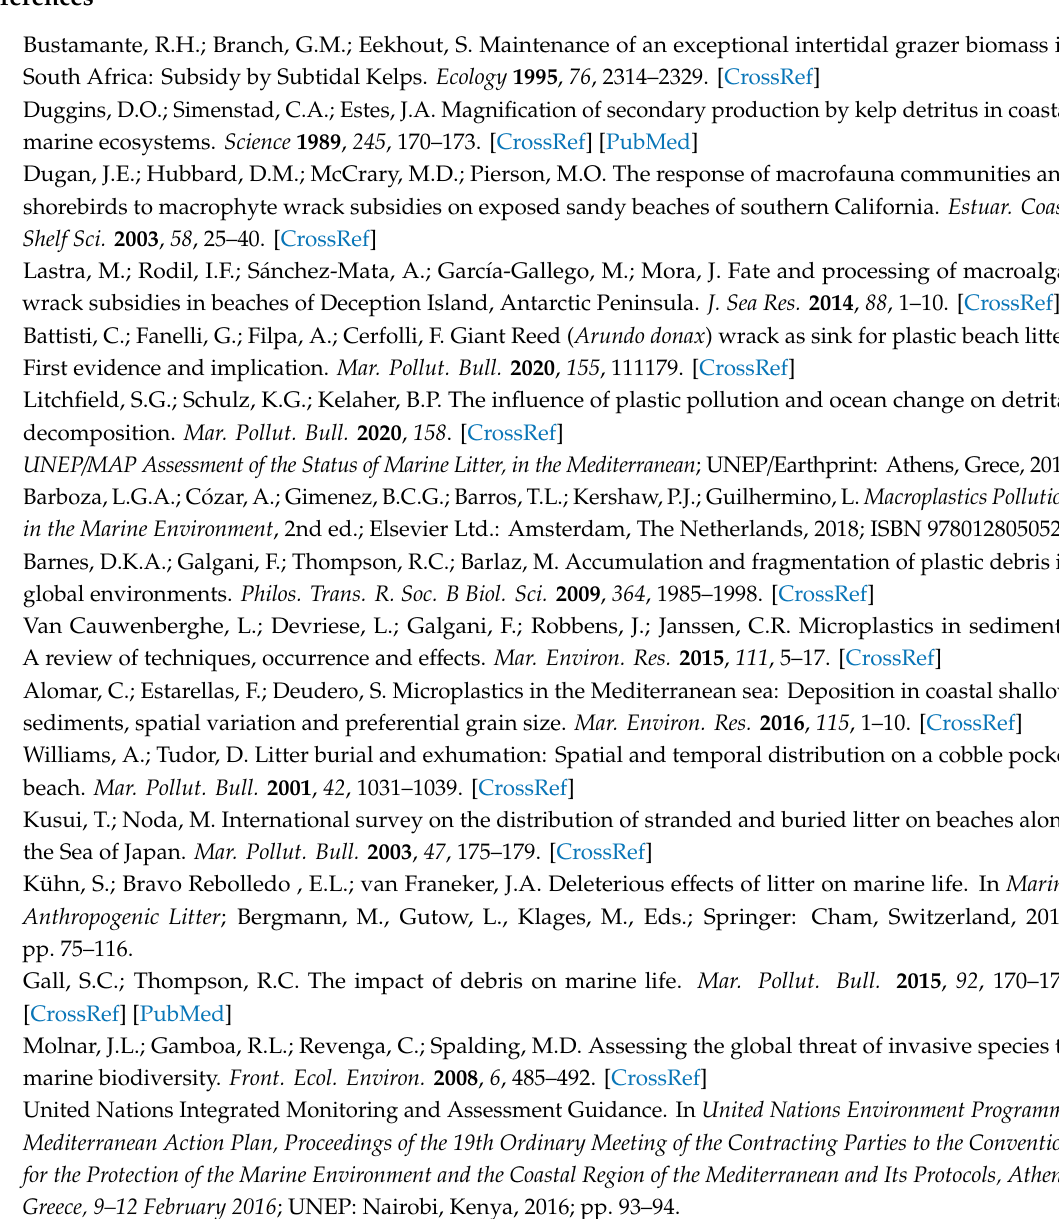
Figure S1: Beaches profiles. Table S1: Sediment characteristics. Table S2: Two-way ANOVA results. Table S3: Macroalgae taxa and marine litter OSPAR categories of the natural wrack and marine